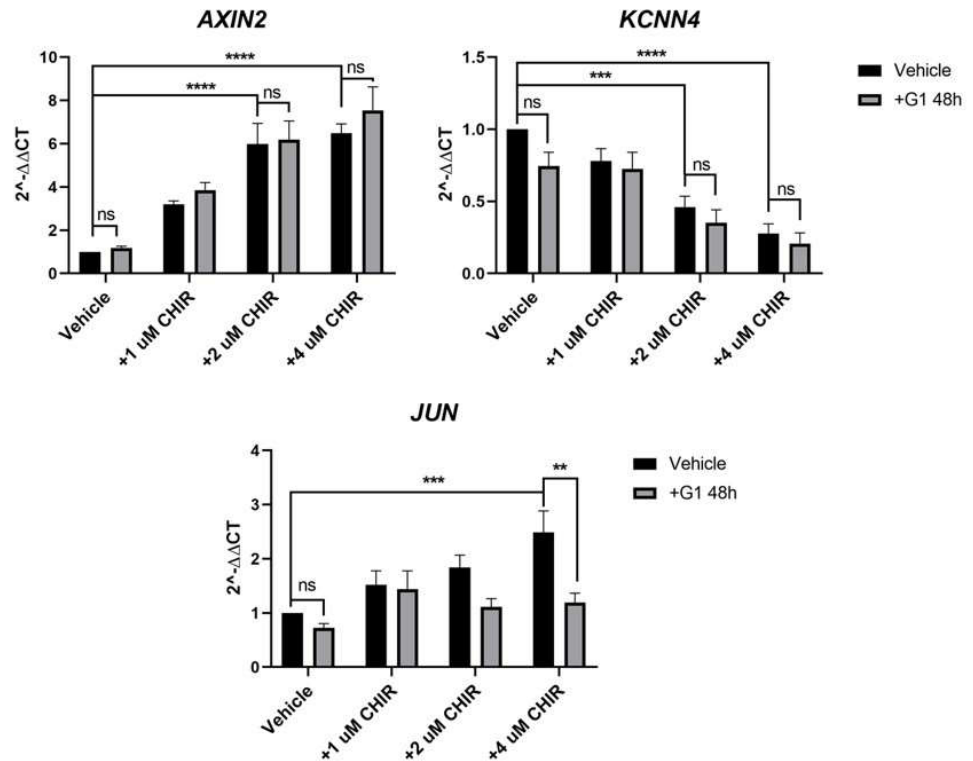
Figure 4. Pre-treatment with G1 prevents CHIR-induced upregulation of JUN in HT29 cells but does not alter CHIR-induced regulation of AXIN2 or KCNN4 . HT29 cells were pre-treated with 0.25 µ M G1 for 24 h and subsequently co-treated with 0.25 µ M G1 and 0 − 4 µ M CHIR for a further 24 h in 1%cds-FBS containing media. RT-qPCR analysis shows CHIR itself increased AXIN2 and JUN expression levels whereas it reduced KCNN4 expression levels in a concentration dependant manner in HT29 cells, reaching the highest significance at the highest CHIR concentrations. Co-treatment of HT29 cells with G1 significantly prevented CHIR-induced increase in JUN mRNA levels. However, G1 did not impact CHIR-induced change in AXIN2 nor KCNN4 expression levels, n = 7. Statistical analysis was performed with a two-way ANOVA analysis with Tukey’s post hoc test. Results from the 2-way ANOVA analysis showed AXIN2 expression levels were significantly impacted by CHIR ( p < 0.0001) but not G1 treatment ( p = 0.2647); in the case of the expression levels of KCNN4 both CHIR ( p < 0.0001) and G1 treatment ( p = 0.0392) were found to exert a significant impact overall; more notably JUN expression levels were shown to be modulated significantly by both CHIR ( p = 0.0004) and G1 treatment ( p = 0.0005). Mean ± SEM; ** p ≤ 0.01, *** p ≤ 0.001, **** p ≤ 0.0001, ns, not